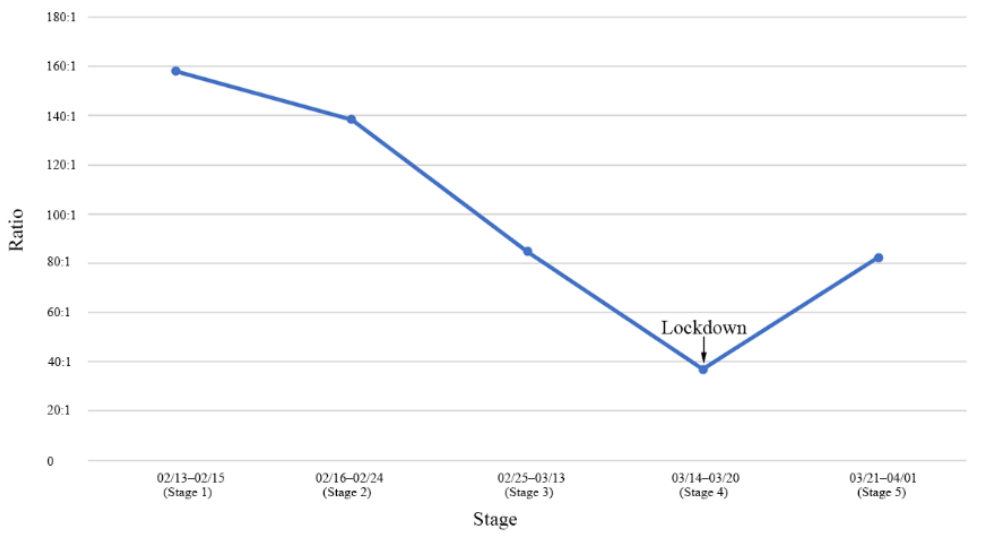
Figure 3. Ratios of the number of daily close contacts and infected cases by different stages